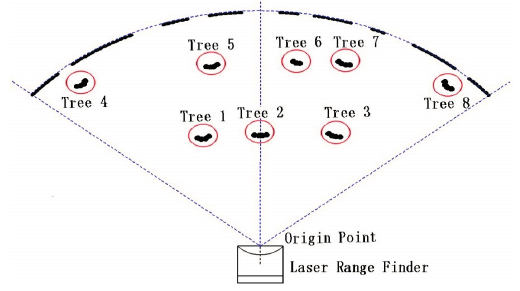
Figure 6. The clustering and filtering result of the experiment in polar form.